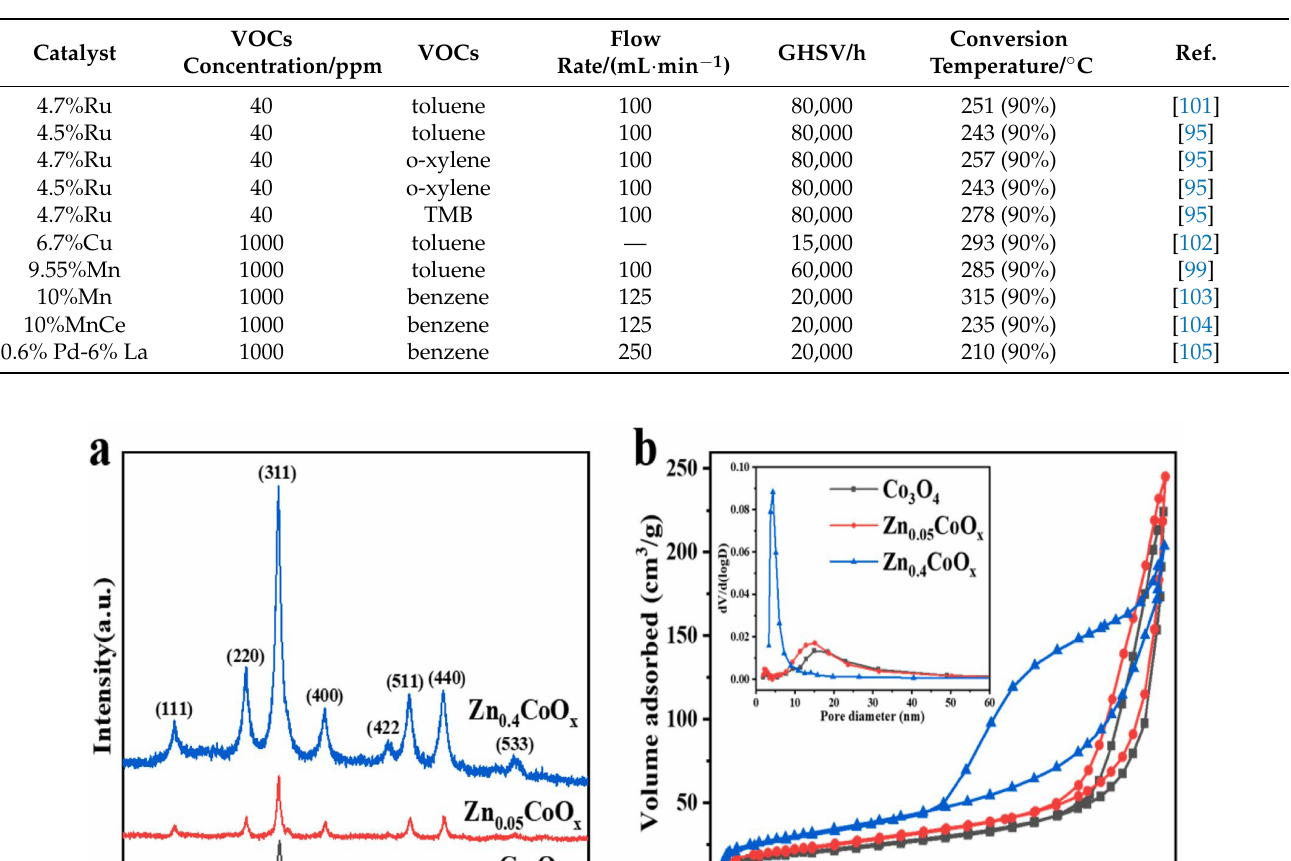
Table 3. Comparison of catalytic oxidation performance of different zeolite-supported catalysts for aromatic hydrocarbon VOCs. Adapted with permission from Ref. [100]. Copyright 2018 Aihu Feng.